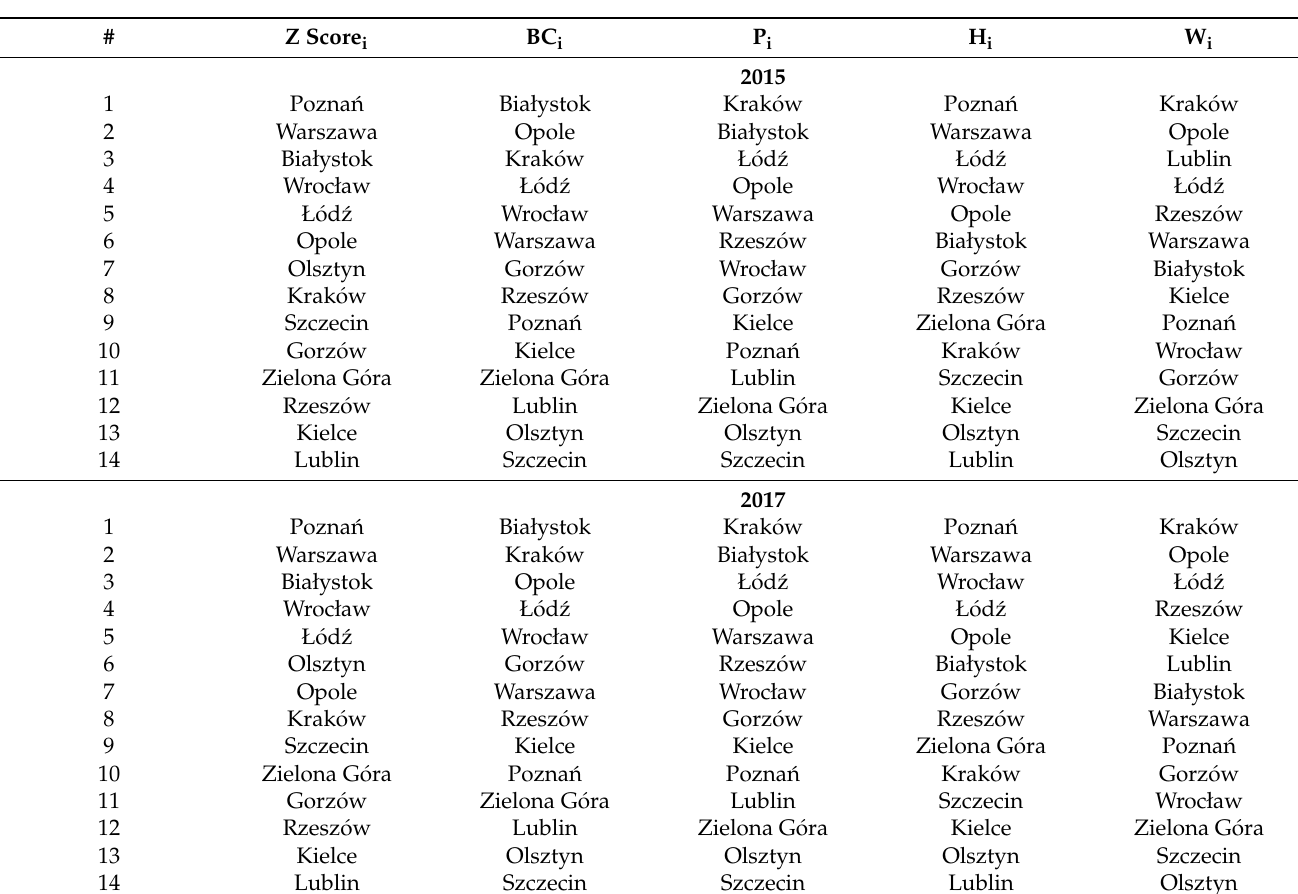
Table 6. Ranking: list of urban areas by order of index.